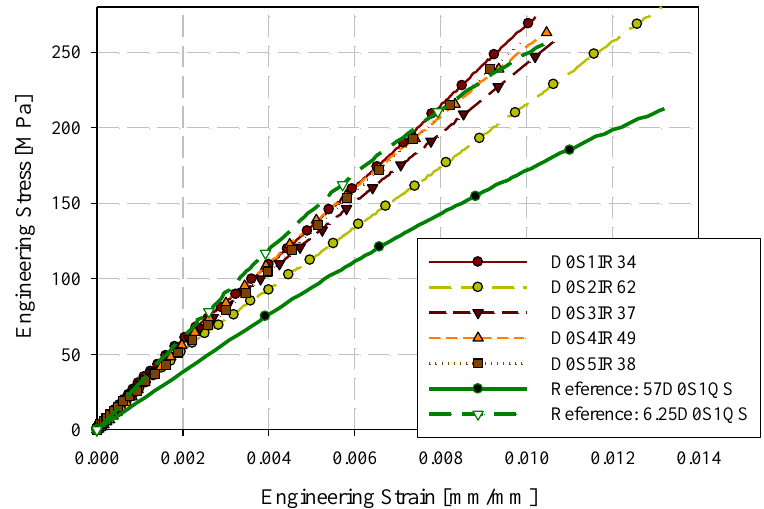
Figure 9. 0-degree intermediate strain rate engineering stress-strain responses with upper and lower bound quasi-static reference responses.